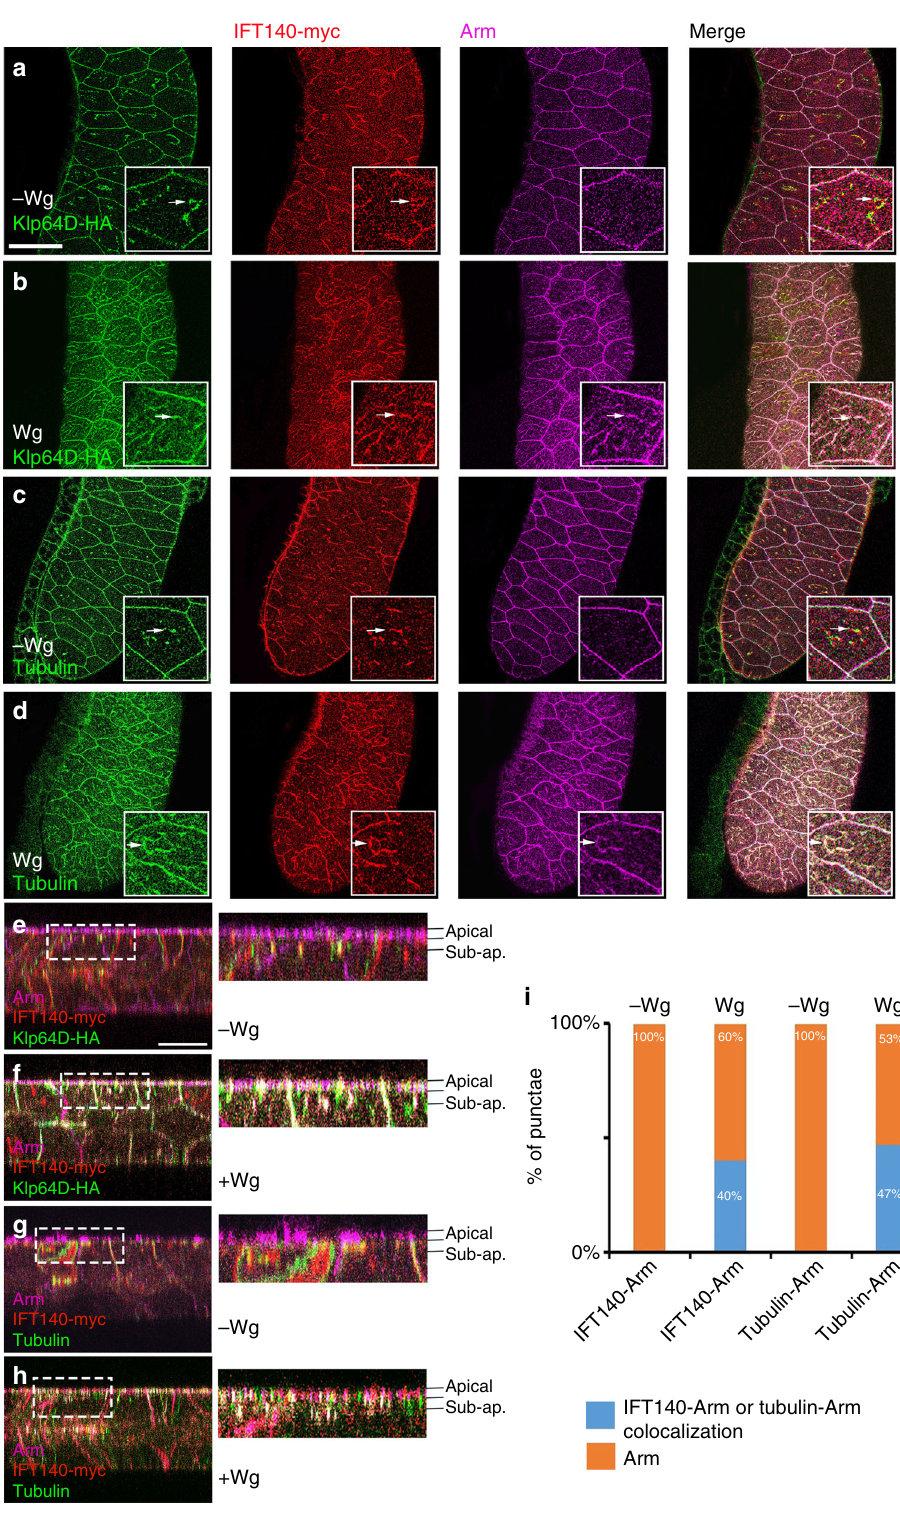
of the Gal4- driver. After establishing these parameters for the “ Wg-signaling salivary gland assay ” , we used the C805-Gal4 > Wg background with LepB treatment and tested for effects of individual Kinesin-2/IFT-A complex RNAi-based knockdowns (KDs) on Arm/ β -catenin